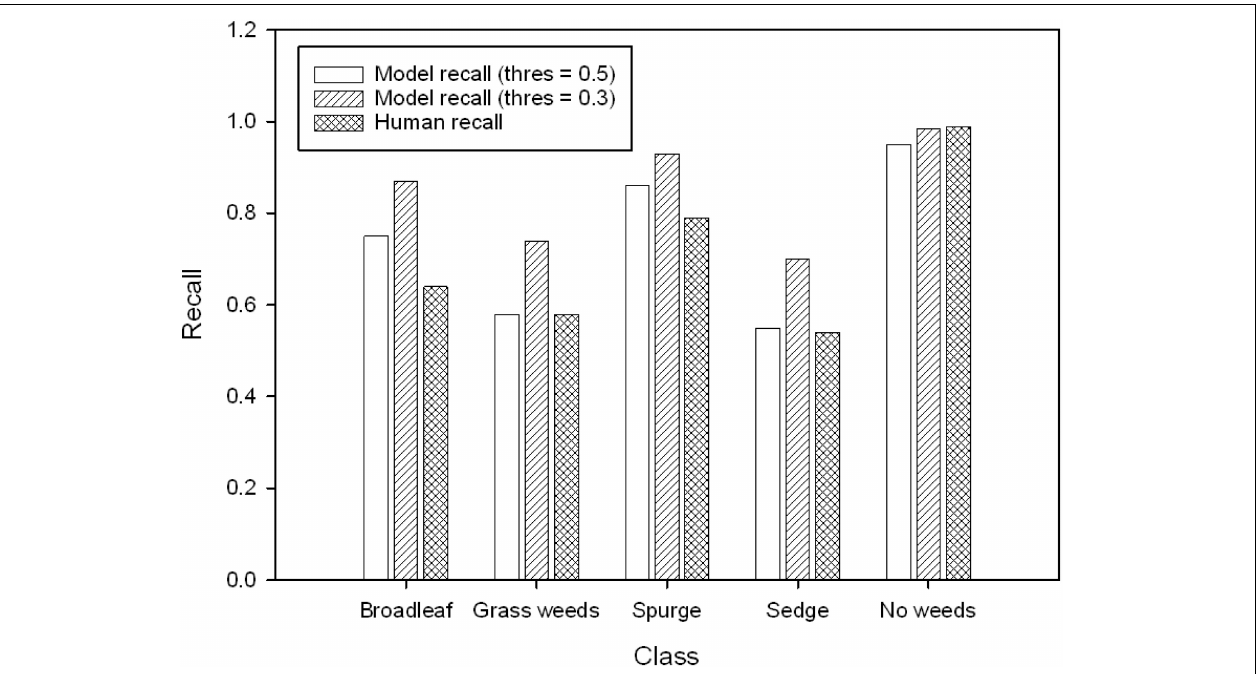
FIGURE 5 | The comparison of recall (threshold values = 0.5 and 0.3) in validation result and recall from human performance (averaged from three evaluators).